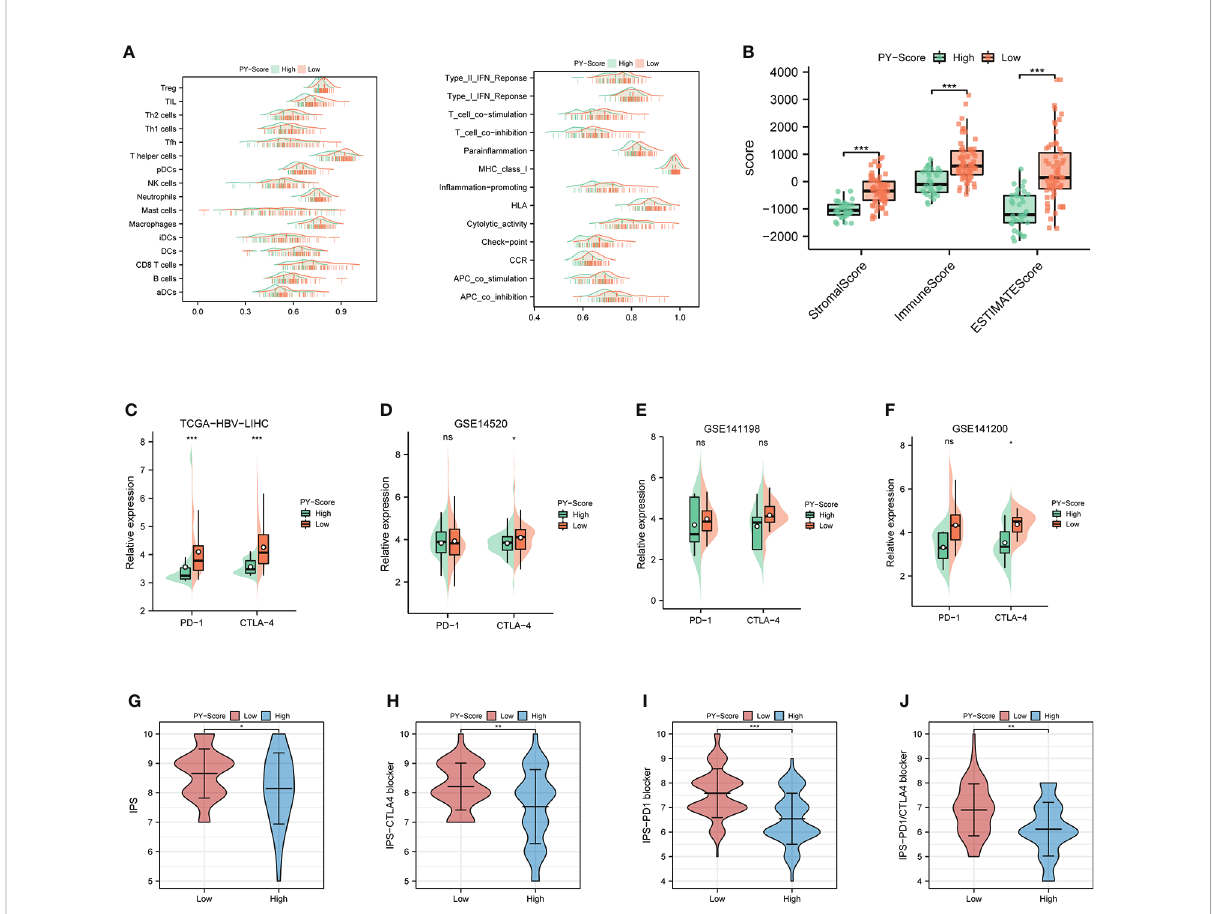
FIGURE 7 Immune landscape and immune checkpoint blockers sensitivity based on PYS. (A) Ridge plot of TIME-based on PYS. (B) tumor microenvironment scores between high- and low-PYS groups. (C – E) The relative expression of PD-1 and CTLA-4 between low- and high-PYS groups in TCGA-HBV-LIHC (C) , GSE14520 (D) , GSE141198 (E) , and GSE141200 (F) cohort. (G – J) The IPS of baseline (G) , CTLA-4 blocker (H) , PD-1 blocker (I) , and PD1/CTLA4 blocker (J) . TIME, tumor immune microenvironment; IPS,immunophenoscore; PYS, pyroptosis score. *P < 0.05; **P < 0.01; ***P < 0.001; ns, not statistically signi fi